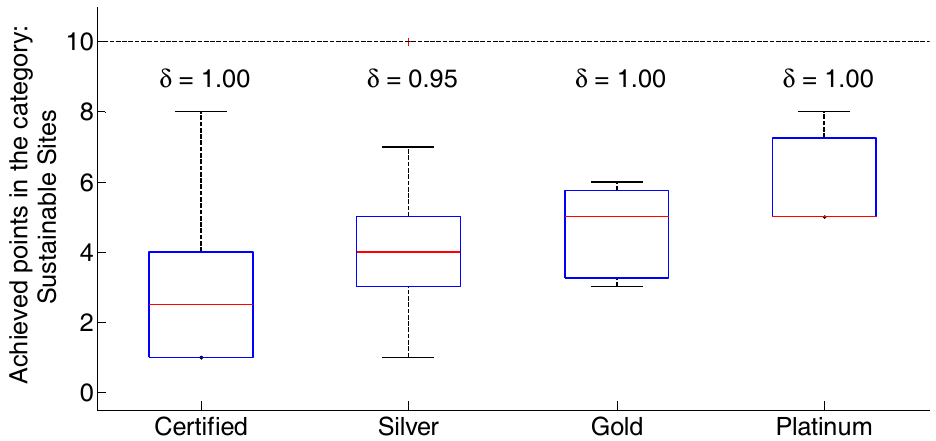
Figure 3. The boxplot results and Cliff’s δ effect size between possible and achieved points in the Sustainable Sites (SS) category. Effect size is considered to be: very high if | δ | < 0.147 (bold font), high if 0.147 < | δ | < 0.33 (bold italic font), medium if 0.33 < | δ | < 0.474 (italic font), and low if | δ | ≥ 0.474 (normal font).